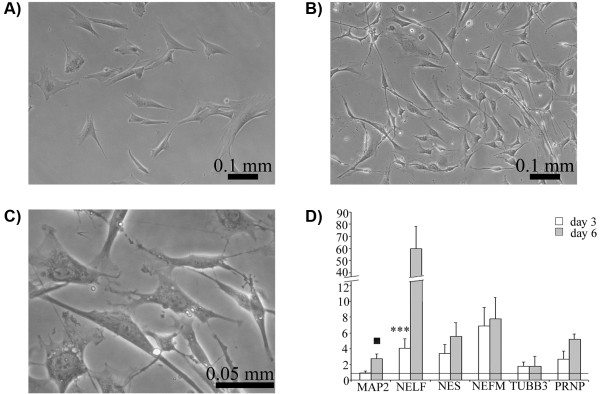
Neurogenic differentiation of PB-MSCs. Phase contrast micrograph of ovine PB-MSCs at passage 3 cultured on basal and neurogenic medium for 3 days. Control cells (A) showed a fibroblast-like shape whereas differentiated cells (B) displayed neuronal-like features such as phase-bright bodies, long multipolar extensions and branching ends (C: higher magnification). Increase of the expression levels of neurogenic markers after 3 (white bars) and 6 (grey bars) days of induction relative to the levels observed in cells cultured on basal medium (values set to 1, horizontal line) as assessed by real time PCR. Data are shown as mean ± standard errors. Statistically significant differences between differentiated and control cells were determined by Student t test (▪ P < 0.10, *** P < 0.001).